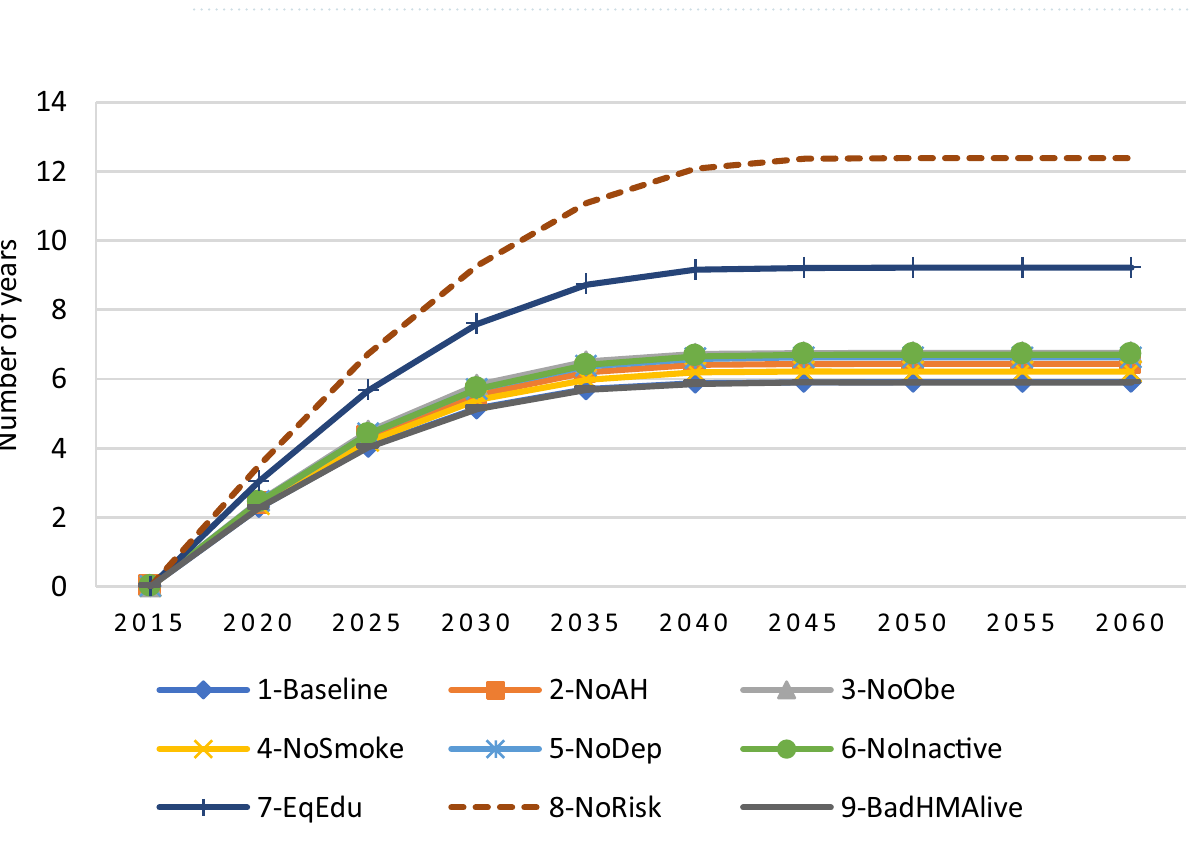
Figure 5. Projected number of years lived per person (NYLP) from 2015 to 2060 under different scenarios.